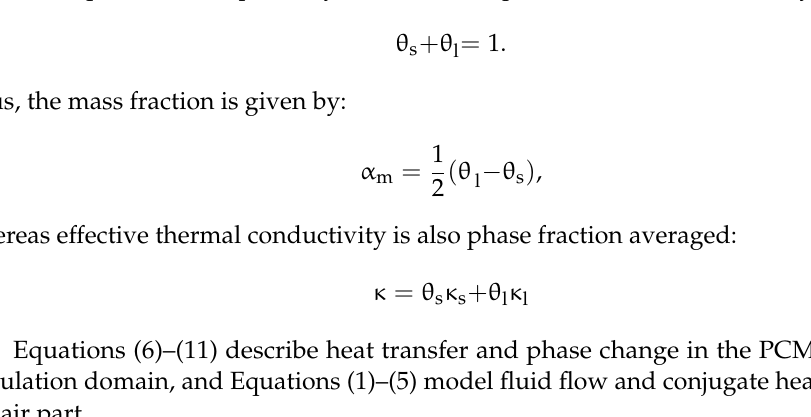
Table 4. Boundary conditions for the PCM–air heat exchanger simulations.